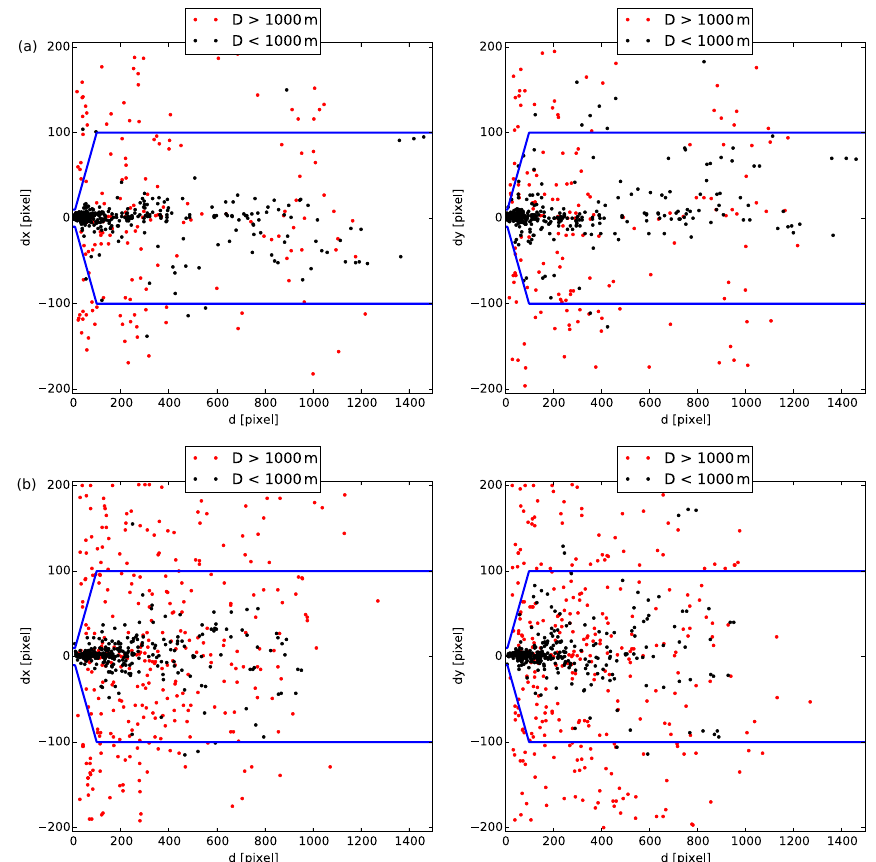
Figure 10. Pattern-matching location adjustment dx and dy in x and y direction vs. distance d to closest feature-tracking vector using (a) HV and (b) HH polarisation. D represents the difference between buoy GPS position and algorithm result. The blue lines indicate the recommended setting for t 2s (Eq. 13) with d min = 10 and d max = 100.